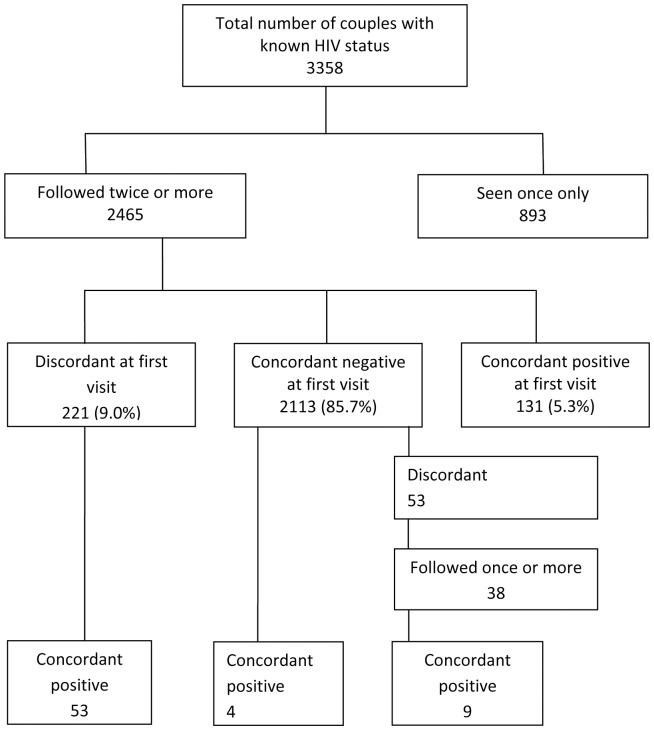
Identification of serodiscordant couples in the General Population Cohort.